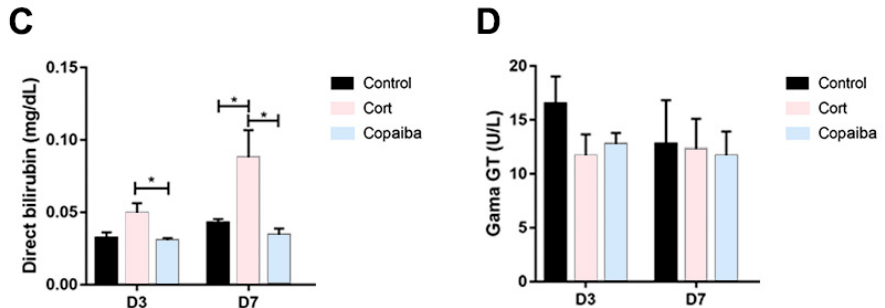
Figure 6. Comparative biochemical parameters levels of liver function in di ff erent groups: ( A ) ALT, ( B ) AST, ( C ) DB and ( D ) GGT (* p < 0.05). Although DB was elevated in the corticoid-treated group on D3 ( n = 15) and D7 ( n = 15) (Figure 6C), GGT levels presented normal levels in all the groups. The results are expressed as the mean ± standard error of the mean. One-way ANOVA and Tukey’s post hoc tests (* p <